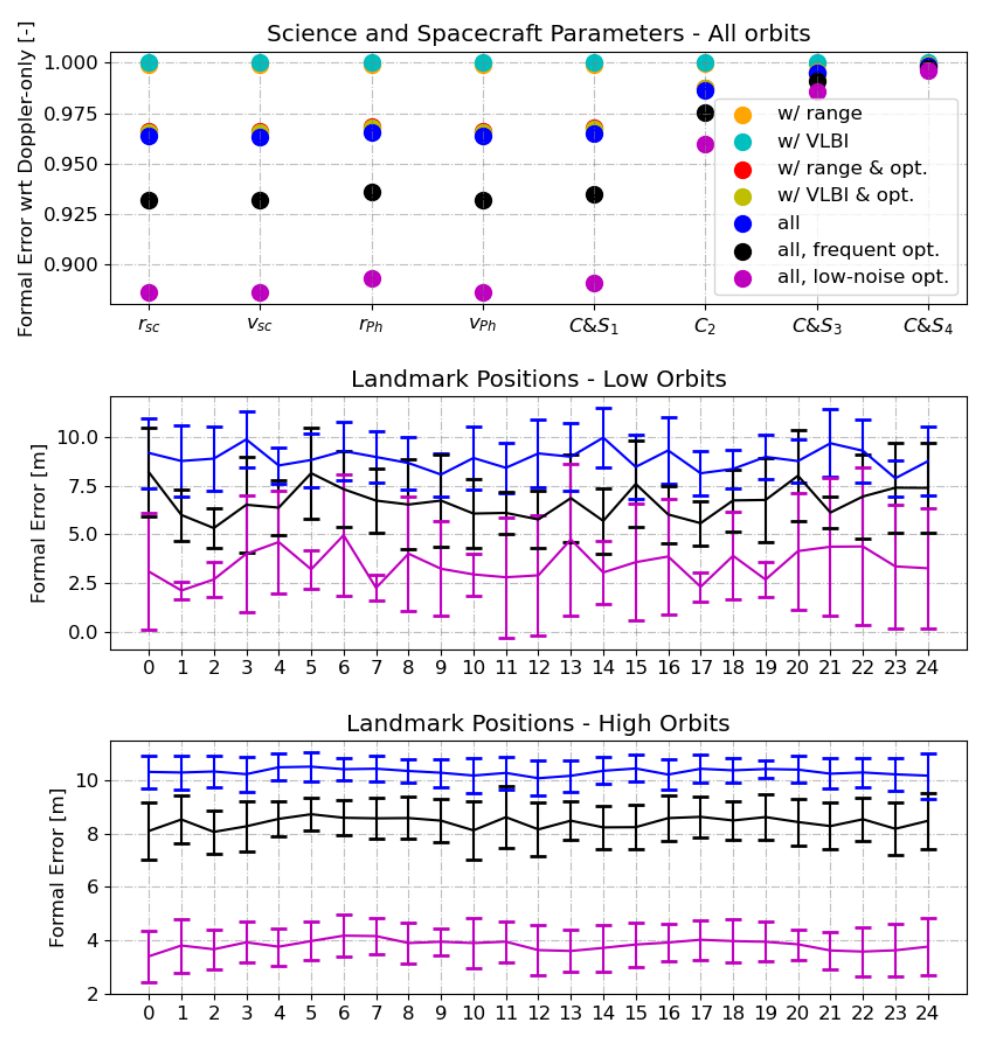
Figure 9. ( Top ): orbit-averaged contribution of tracking data types on formal errors with respect to Doppler-only case for all parameters. ( middle and bottom ): influence of optical instrument performance (noise and image frequency) on landmark position accuracy. Markers and lines show mean, bars show maximum/minimum values. This figure only concerns the RS